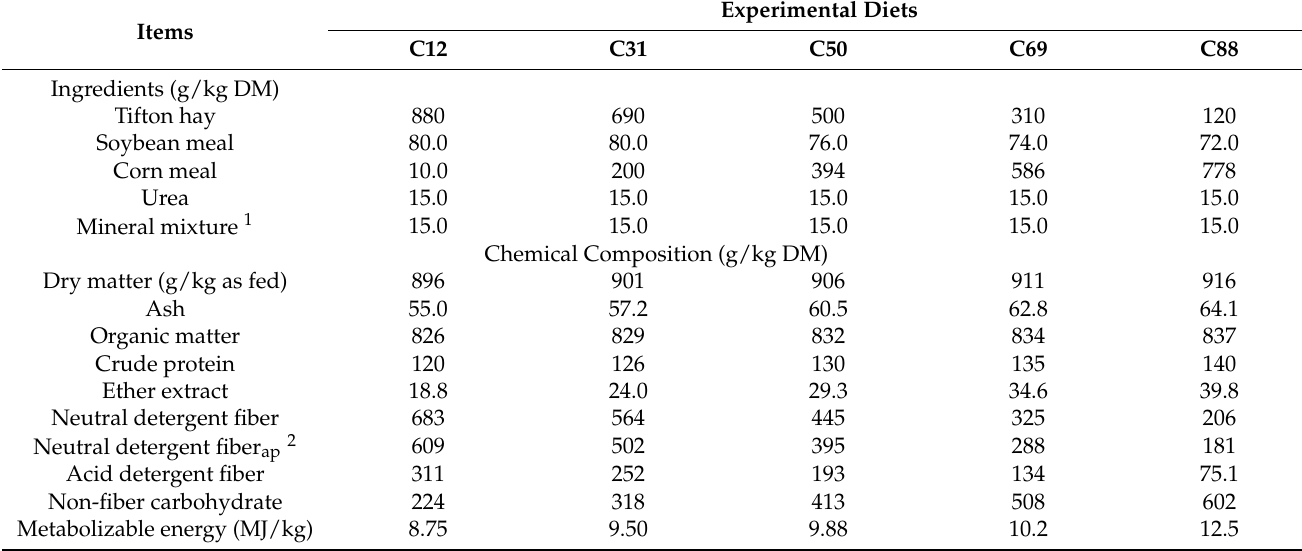
Table 2. Ingredient proportions and chemical composition of experimental